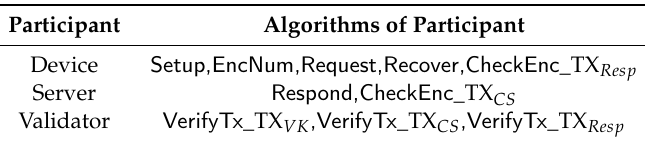
Table 1. Affiliation of